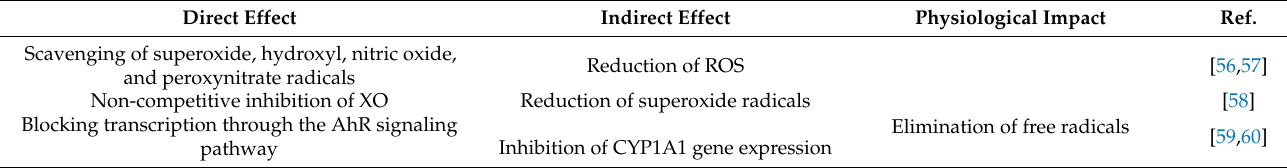
Table 1. Direct and indirect effects of resveratrol on breast